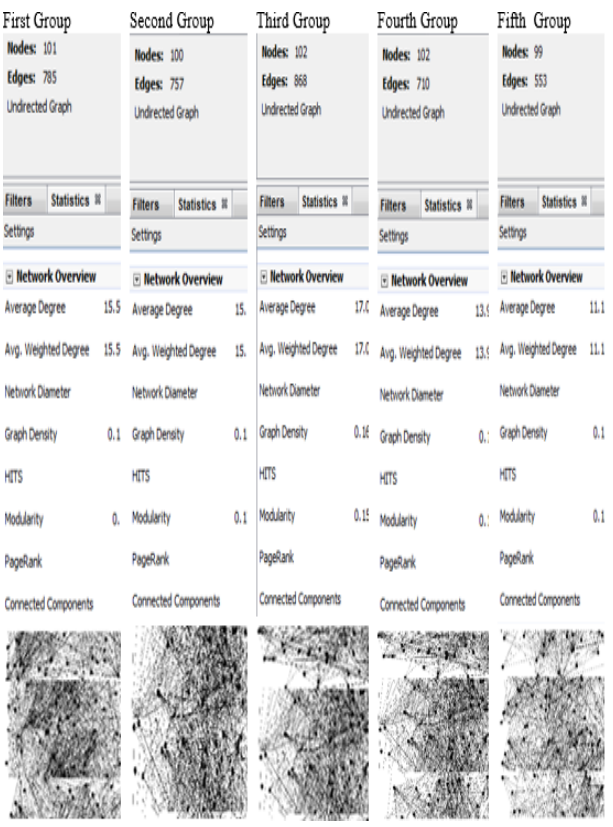
Figure 7. Full network graph as nodes and edges We grouped our nodes with their edges to five groups see Figure 8, our reduced graph contains 47,972 tags but we just took 500 tags (valuables) that have the highest frequency degree to visualize the graph. Figure 8 shows these grouping for tags and some statistical information we will explain it in more details.